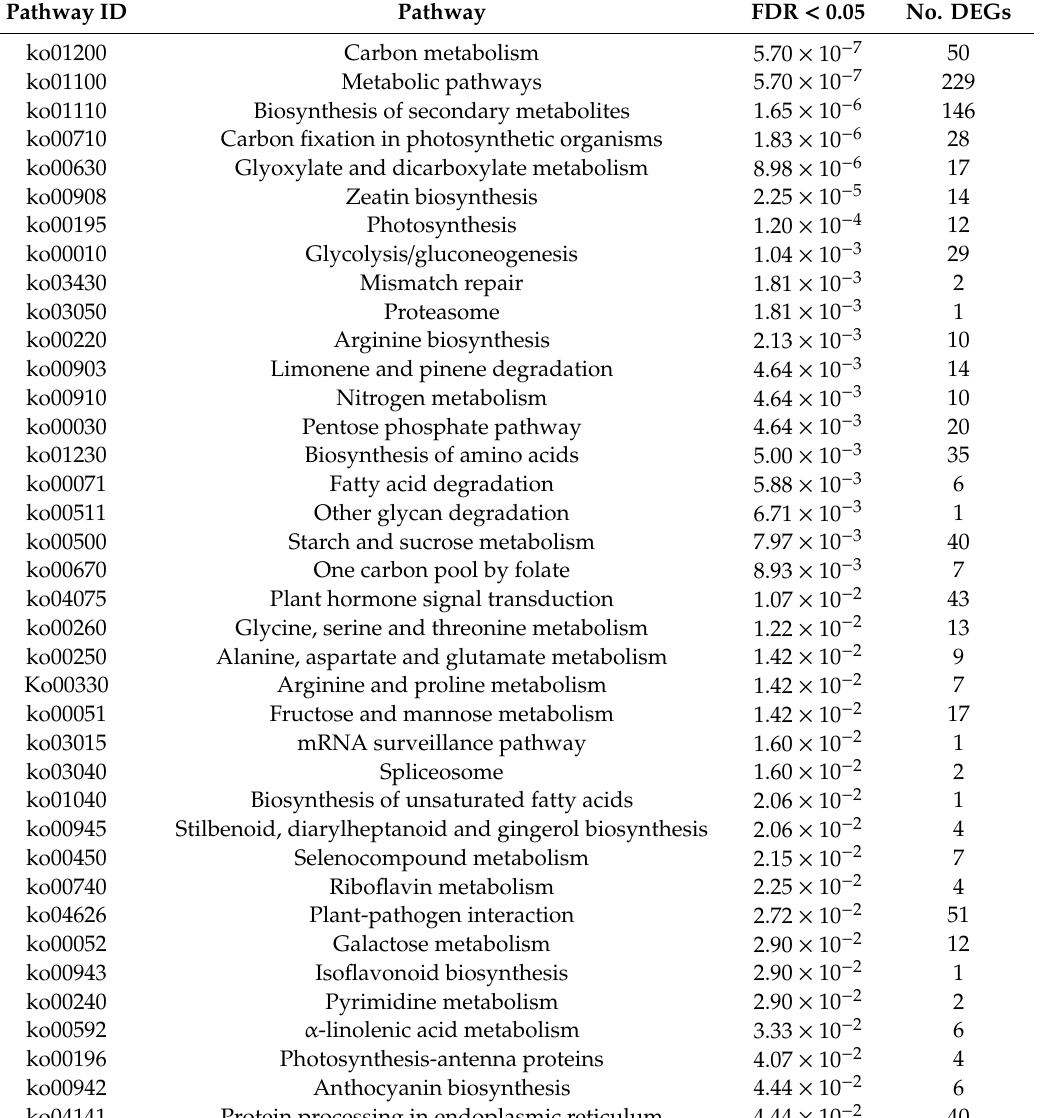
Table 3. Pathways from six cross-comparisons between the di ff erent gene